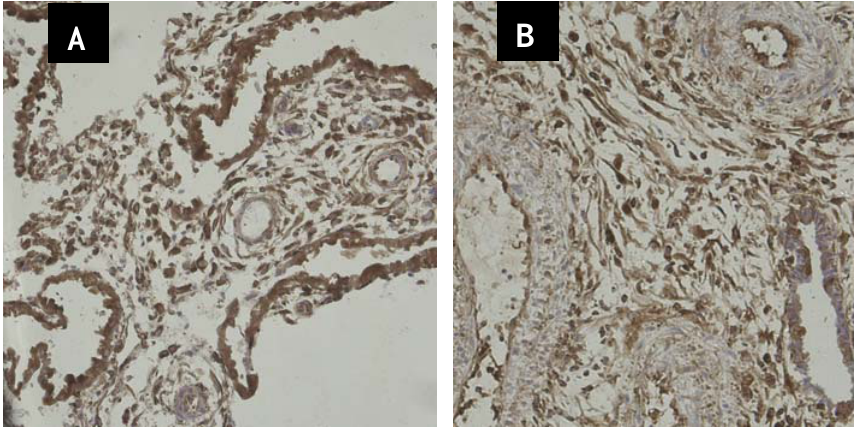
Figure 2. Significantly higher staining score with NF- κ B in decidual stromal cells and lower staining score with NF- κ B in decidual glandular epithelial cells in the SM group than in the control group by immunohistochemistry. (A) Control; (B) Early spontaneous miscarriage. SP ×